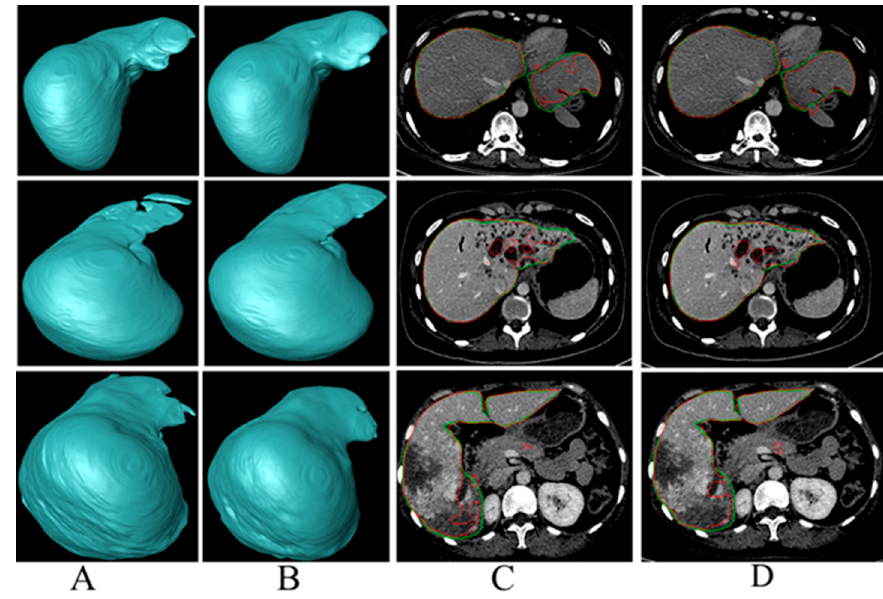
Figure 3. Results of Liver segmentation using FCN model. ( A , B ) display the 3D liver segmentation result of the baseline and proposed a model, respectively; ( C , D) display the hard samples liver segmentation results of the baseline and proposed a model, respectively; Blue and red lines in C and D denote ground truth and prediction results. Each row shows results acquired from an individual case.